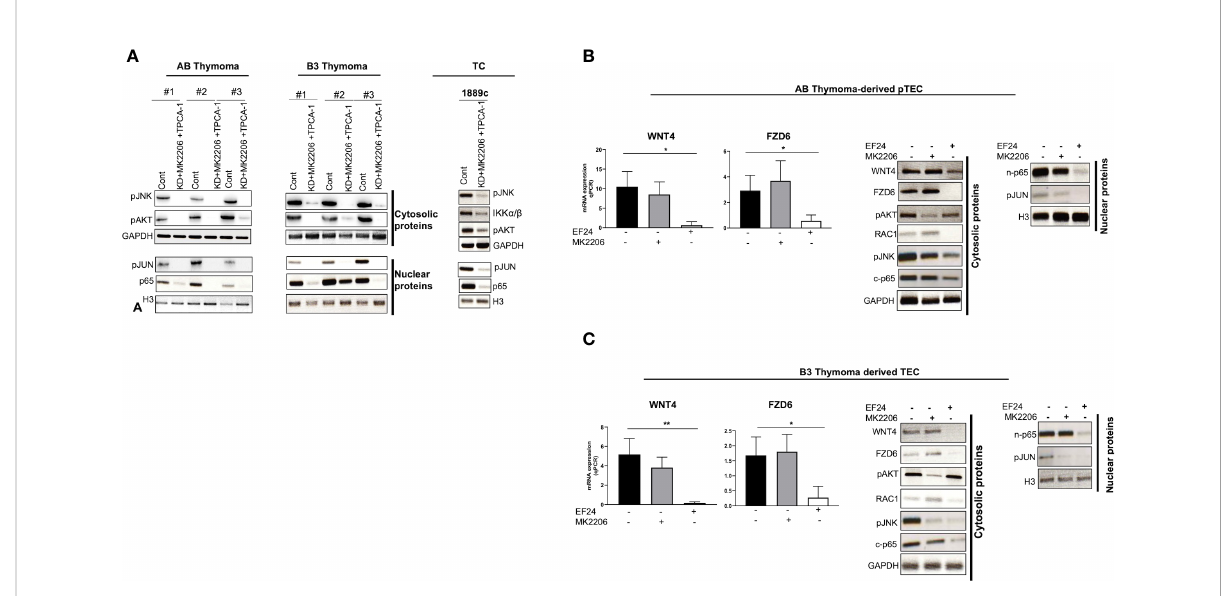
FIGURE 7 NF- k B activated non-canonical WNT4/PCP pathway. (A) : pJNK inactivation and down-regulation of pAKT and NF- k B (p65) in AB and B3 thymoma-derived pTECs (n = 3 each) and thymic carcinoma 1889c cell line, which were fi rst transfected with pU6WNT4-shRNA, then treated with MK2206 and TPCA1 that target pAKT and IKK a / b (NF- k B pathway), respectively; (B, C) : pJNK down regulation by targeting p65 (NF- k B) or pAKT in AB and B3 thymoma-derived pTECs (n = 1 each); pTECs were treated either with 1 µM EF24 or 2 µM MK2206 for 48 h that target p65 (NF- k B) and pAKT respectively. WNT4 and FZD6 mRNA levels were quanti fi ed using Q-PCR. Cytosolic and nuclear proteins were isolated then analyzed by western blot for the following molecules: WNT4, FZD6, RAC1, pJNK, pAKT, p65, and pJUN. GAPDH and H3 were used as loading control. Cont, either with sh-wnt4 transfected nor drug treated cells; c-p65, Cytosolic p65; n-p65, Nuclear p65. *p<0.1,